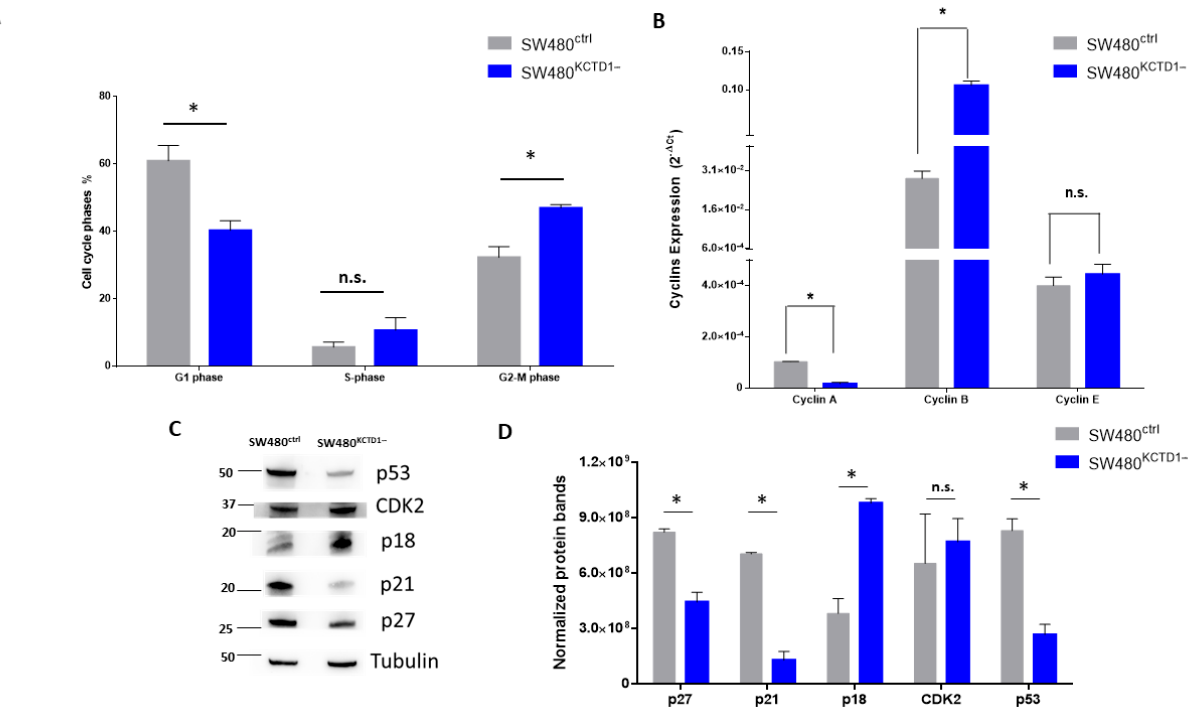
Figure 5. ( A ) The percentages of cells in the G0–G1, S, and G2–M phases after 72 h of active growth were reported as the mean values of three independent experiments +/ − SD. * = p < 0.05. Mann– Whitney t -test ( B ) mRNA expression levels of cyclins in SW480 ctrl (grey bars) and SW480 KCTD1 − (blue bars) after 72 h of active growth. Relative expression was determined using the 2 −Δ Ct method. Relative expression of cyclins is shown as mean +/ − SD of two technical independent experiments. * = p < 0.05, Mann–Whitney t -test. Western blot analysis of the indicated proteins ( C ) and protein band quanti fi cations ( D ) were performed in SW480 ctrl (grey bars) and SW480 KCTD1 − (blue bars) after 72 h of active growth. Numbers represent molecular weights of proteins expressed in kDa. ns = not signi fi cant; * = p < 0.05.